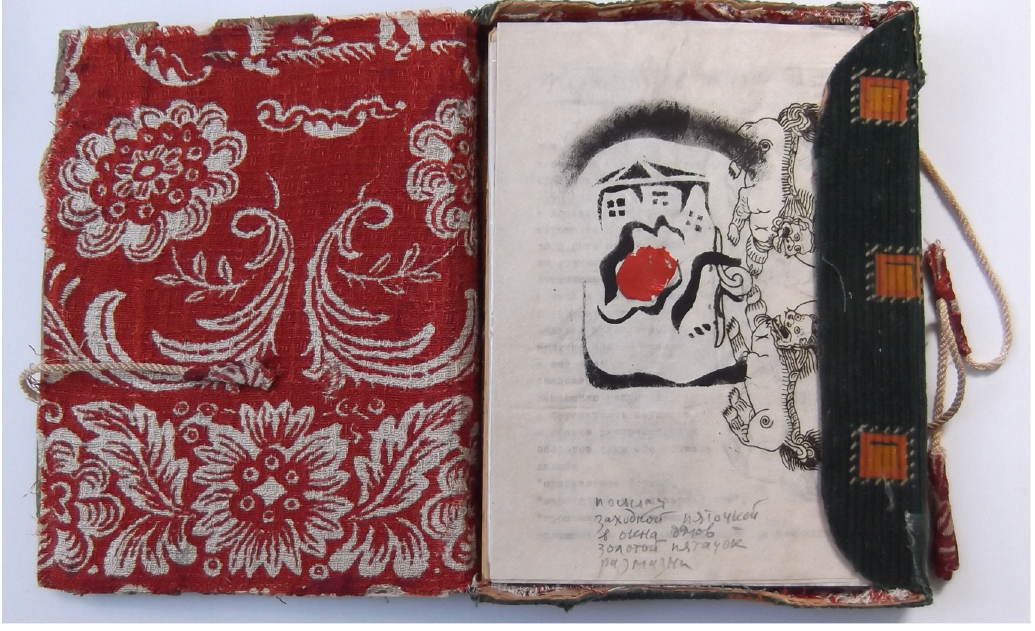
Figure 13. Inside of the box.